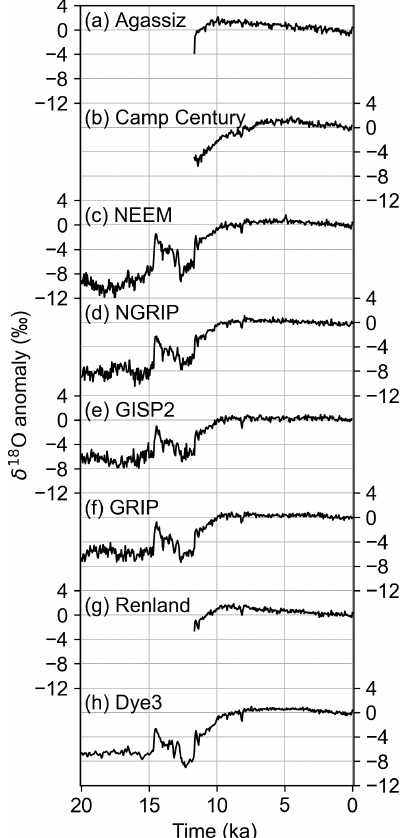
Figure 2. δ 18 O records assimilated into the temperature reconstruc- tion. Records are shown as anomalies relative to the mean during 1850–2000 CE and are ordered top to bottom from northernmost to southernmost. Ice-core site names are given above each